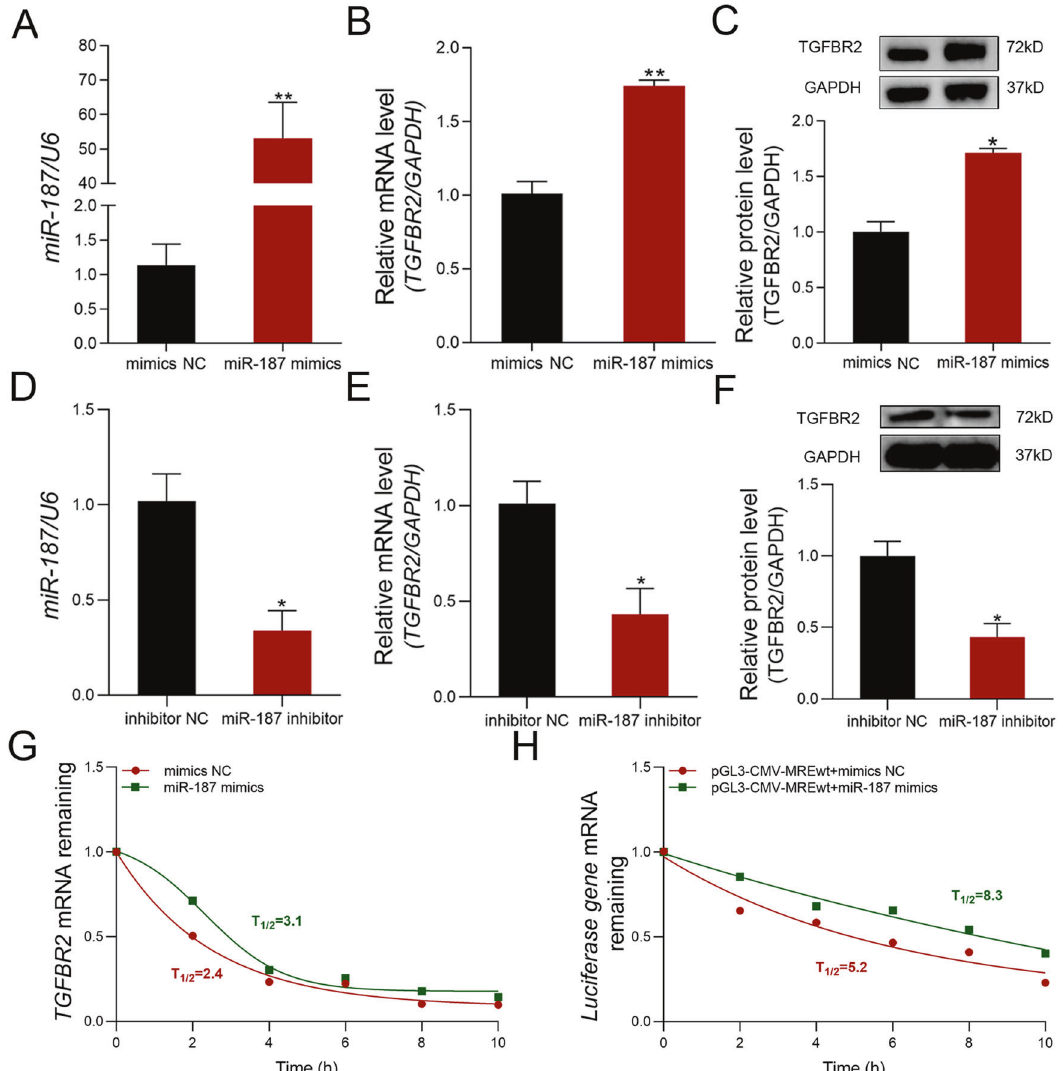
Fig. 2 miR-187 maintains TGFBR2 levels in GCs by in fl uencing their stability. A – C After incubating GCs with miR-187 mimics, levels of miR- 187 ( A ), TGFRB2 mRNA ( B ), and TGFBR2 protein ( C ) were measured. D – F After incubating GCs with miR-187 inhibitor, levels of miR-187 ( D ), TGFRB2 mRNA ( E ), and TGFBR2 protein ( F ) were measured. G , H mRNA stability assays. G After transfection of miR-187 mimics or mimics NC into GCs for 10 h, ActD was added, then TGFBR2 mRNA levels were detected at 0, 2, 4, 6, 8, and 10 h. H After co-transfection with the plasmid pGL3-CMV-MREwt and miR-187 mimics or mimics NC into KGN cells for 10 h, ActD was added, then fi re fl y luciferase gene mRNA levels were detected at 0, 2, 4, 6, 8, and 10 h. Data are represented as means ± SEM for three independent experiments. * p < 0.05; ** p <